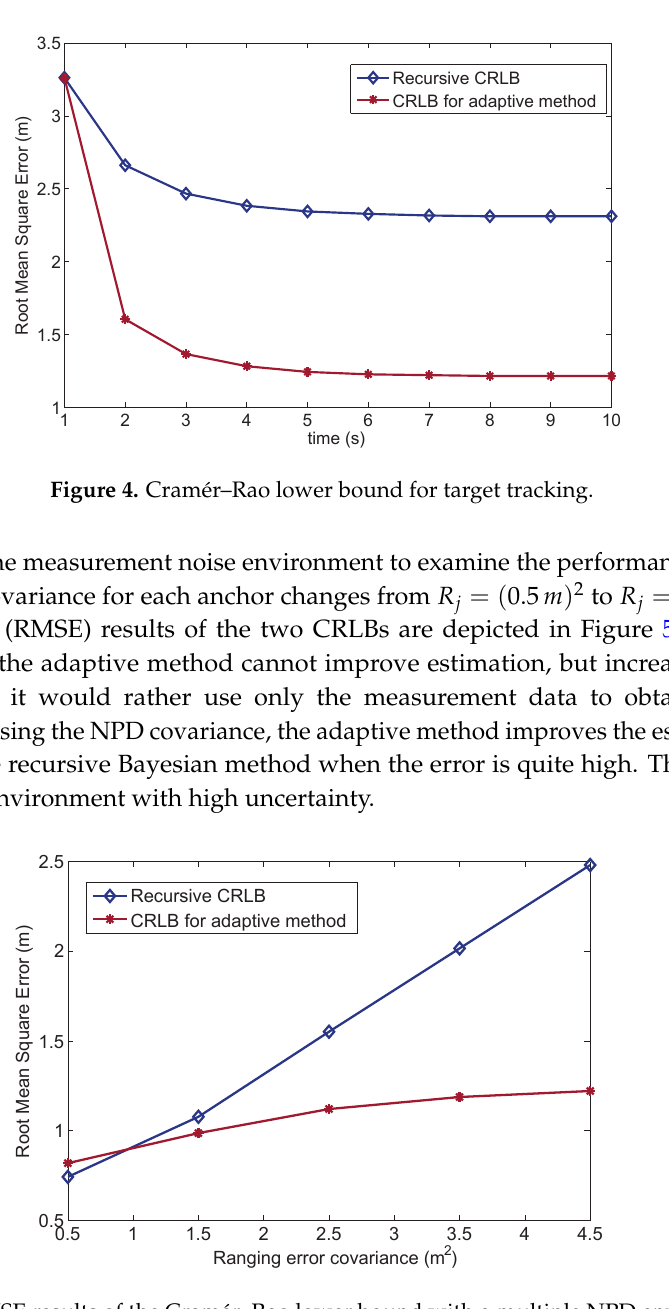
Figure 5. RMSE results of the Cramér–Rao lower bound with a multiple NPD